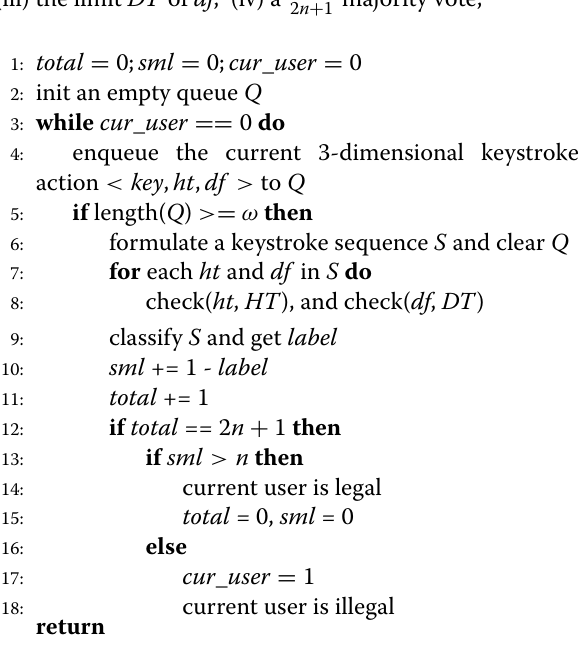
Algorithm 1 TKCA